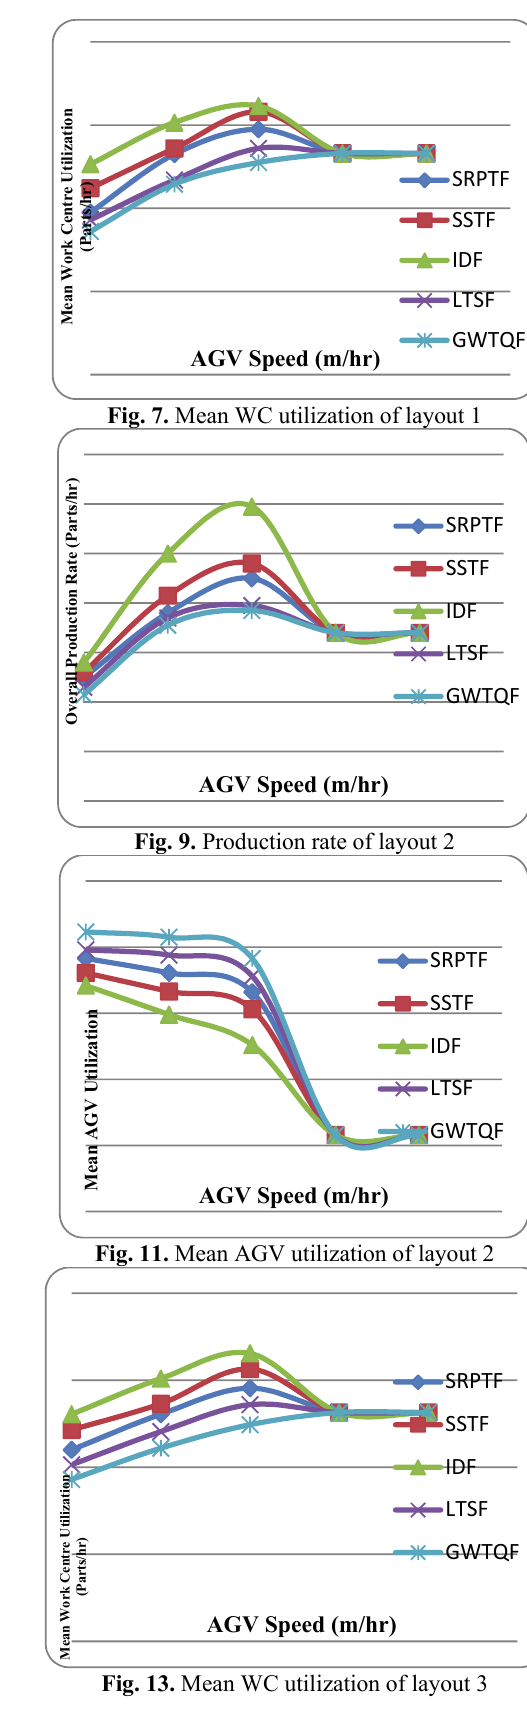
Fig. 6. Production rate of layout 1 Fig. 7. Mean WC utilization of layout 1